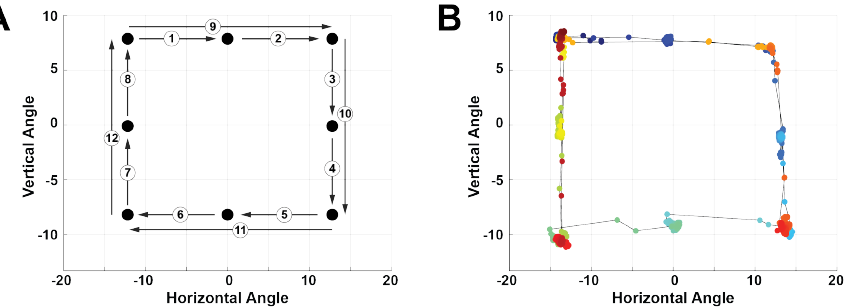
Figure 4: Experimental protocol for the saccade phase of each trial. (A) Pattern followed by the target stimulus on the screen. The numbers indicate the order of the jumps. (B) Data obtained by the video-based eye tracker, color-coded by time with blue being the start of the trial and red being the